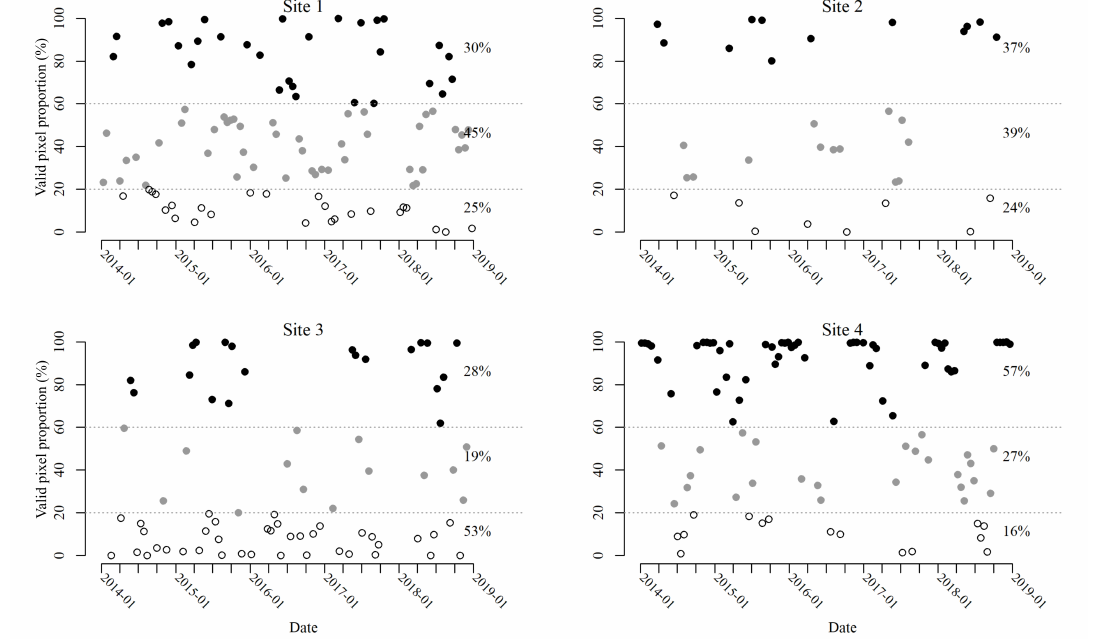
Figure 3. Time series valid pixel proportion (%) for the four sites: Site 1 (Taita Taveta, Kenya), Site 2 (Pirkanmaa, Finland), Site 3 (Brandenburg, Germany), and Site 4 (Tibet, China). The horizontal dashed line shows the 20% and 60% level. The unfilled circles are images that have valid pixel percentage under 20%; grey filled circles are images that have valid pixel percentage between 20% and 60%; black filled circles are images that have valid pixel percentage over 60%. The percentage of images for each level is shown on the right side of each panel. Images that were entirely covered by clouds and cloud shadows are not